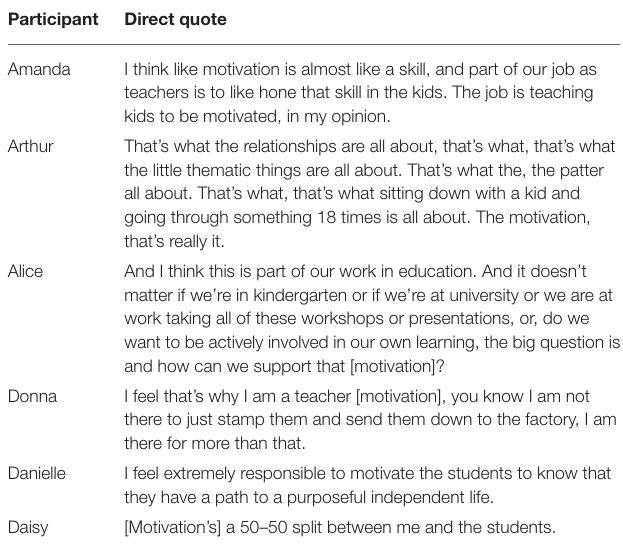
TABLE 3 | Participant statements on responsibility for student motivation as core to their